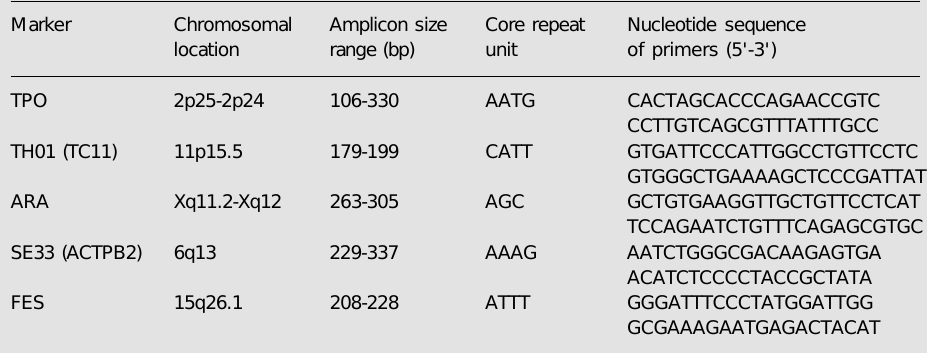
Table 1. Synthetic oligonucleotides used in this study. Marker